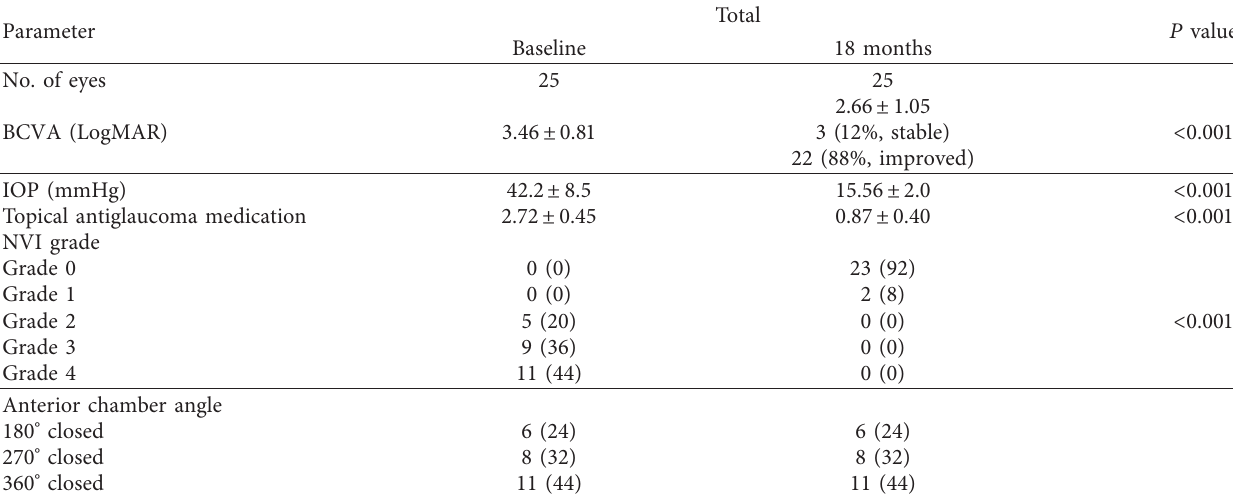
Table 2: Treatment results at 18-month follow-up.